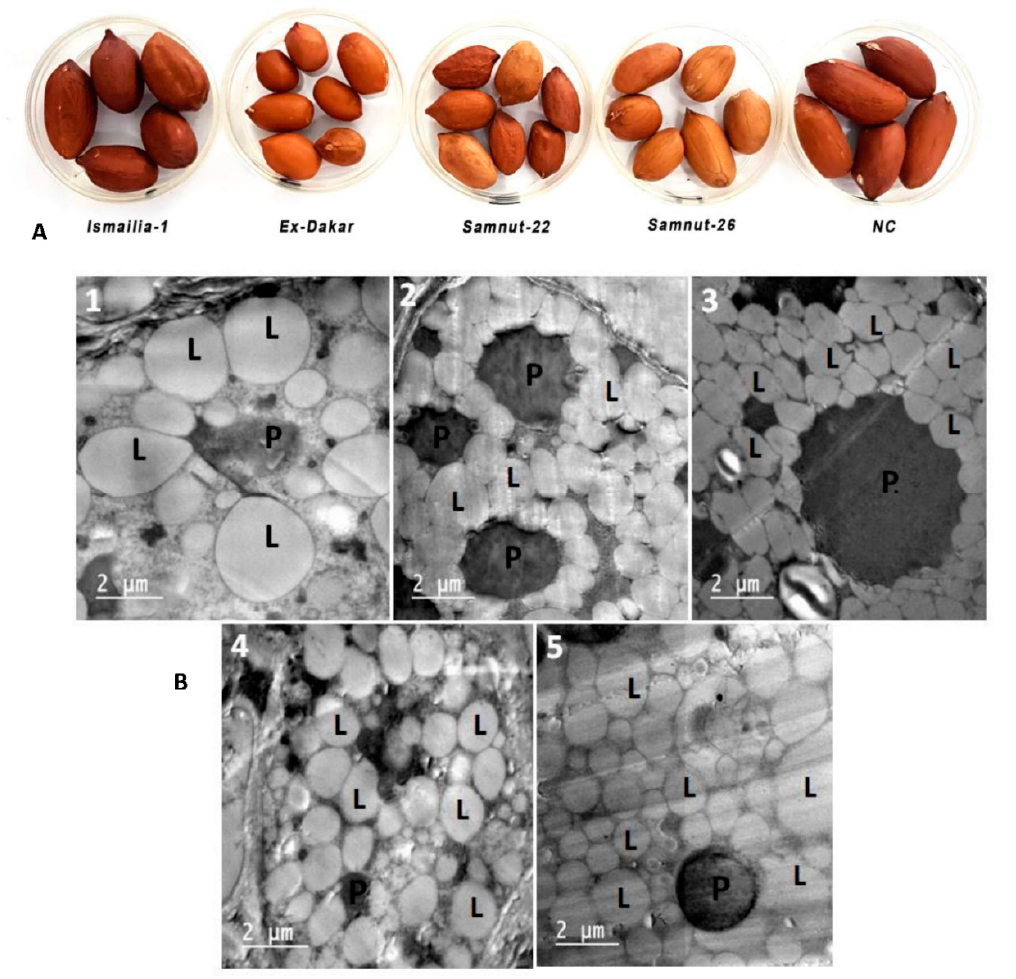
Figure 2. ( A ) Picture of five cultivar seeds. ( B ) Transmission electron microscope (TEM) picture of five peanut cultivars: (1) Ismailia-1, (2) Ex-Dakar, (3) Samnut-22, (4) Samnut-26, and (5) NC-7. Bars represent 2 μ m (P—protein bodies; L—oil bodies).